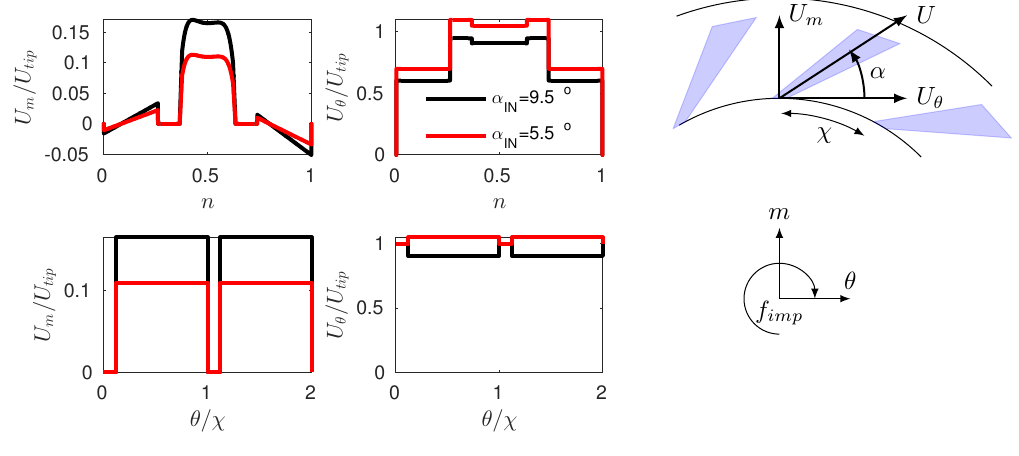
Figure 2. Scaled meridional and tangential velocity profiles applied at the diffuser inlet boundary condition for the two different flow angle cases considered. The graphs on the top row of the figure are for a station between the blades (i.e., θ / χ = 0.5). The graphs on the bottow row of the figure are for the midpoint between the hub and the shroud (i.e., n = 0.5). The small sketch to the right illustrates that the flow angle α is defined with respect to the tangent.